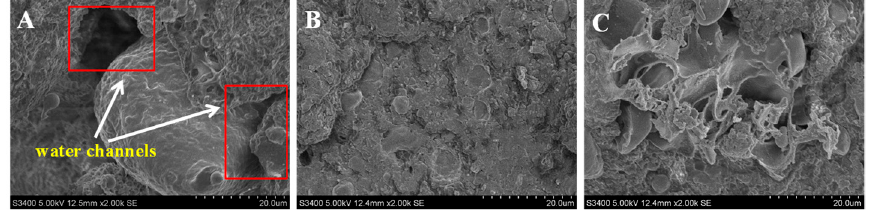
Figure 3. Scanning electron microscopy image of frankfurters with or without AMG at different concentrations. The magnification was 2000×. ( A ): Control group; ( B ): AMG-0.3% group; ( C ): AMG-0.5% group. Control: no added AMG; AMG-0.3%: 0.3% added AMG; and AMG-0.5%: 0.5% added AMG.